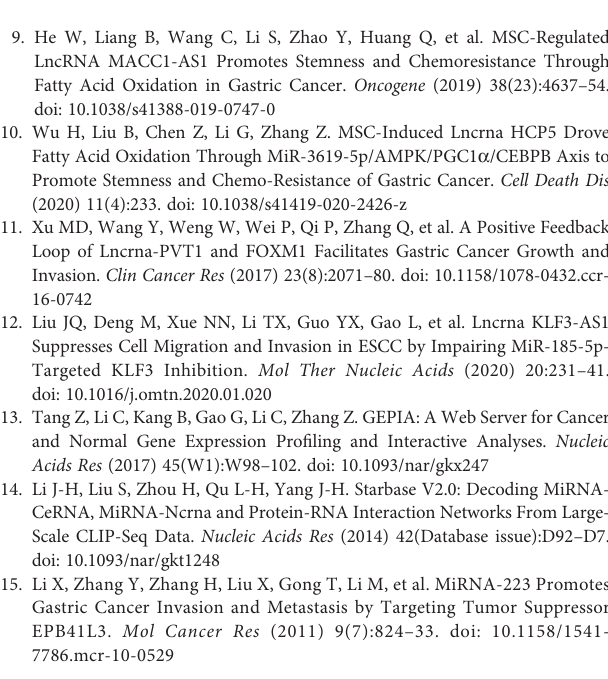
Supplementary Figure 1 | Expression and survival analysis of KLF3-AS1 in gastric cancer. (A) TheexpressionofKLF3-AS1 in gastric cancer tissues and normal gastric tissues. (B) The association between KLF3-AS1 expression and overall survival of gastric cancer patients was indicated by the Kaplan-Meier